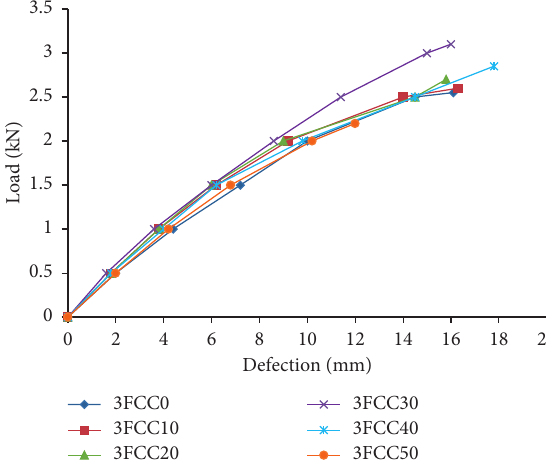
Figure 7: Load vs. deflection for ferrocement laminates with volume fraction